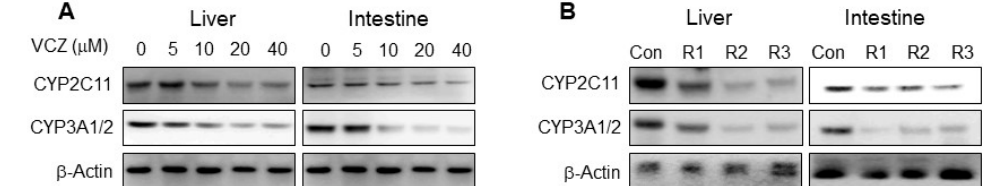
Figure 5. Protein expression of CYP2C11 and CYP3A1/2 in hepatic and intestinal microsomes in vitro ( A ) and in vivo ( B ). For in vitro samples, freshly isolated rat hepatic and intestinal microsomes were treated with voriconazole (VCZ) at concentrations of 5, 10, 20 and 40 µ M and incubated for 30 min at 37 ◦ C. For in vivo samples, the hepatic and intestinal microsomes were obtained from 3 rats 30 min after the oral administration of voriconazole at dose of 20 mg/kg to rats. β -Actin was used as a loading control.